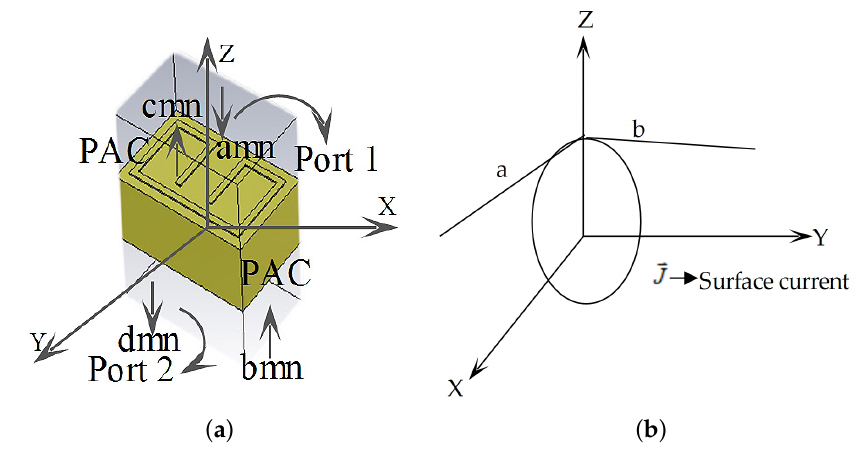
Figure 1. ( a ) Unit cell metamaterial. ( b ) Decomposition of surface